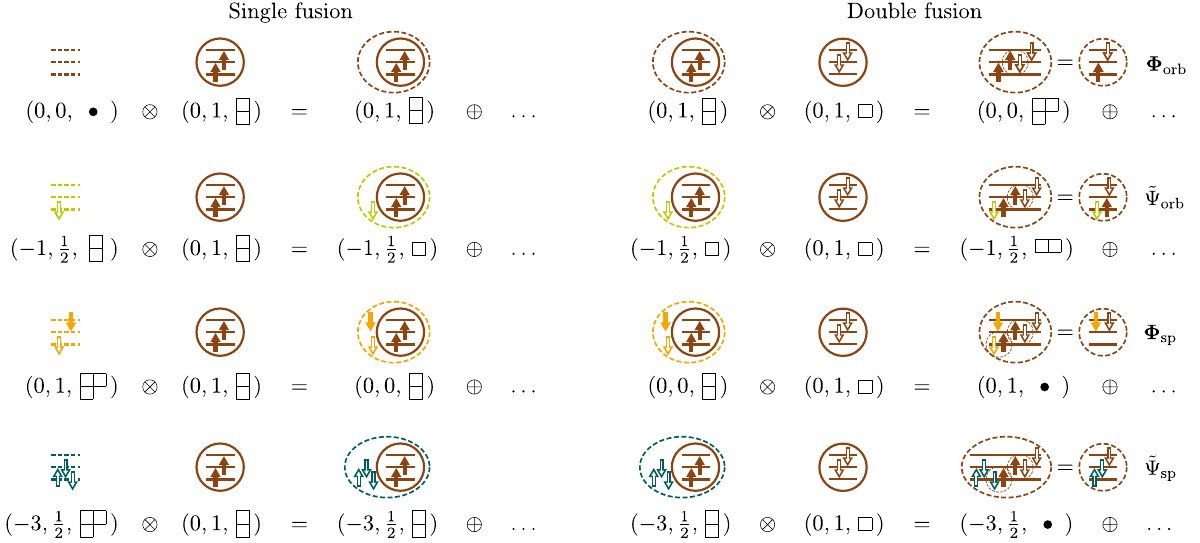
FIG. 3. Schematic depiction of single fusion (left) and double fusion (right), for the four multiplets giving rise to the boundary ˜ Ψ ˜ Ψ operators Φ , Φ , , discussed in Sec. IV (corresponding to rows 1, 3, 4, 5 in Table I). Filled arrows represent electrons, empty orb sp orb sp arrows represent holes. An electron with spin ↑ and a hole with spin ⇓ (missing electron with spin ↑ ) can be combined to annihilate each other, as indicated by small dashed circles in the last column. Our illustrations depict the impurity using a fermionic representation, as would be appropriate for the 3oAH model, even though the 3soK impurity has no charge dynamics. In the “ single fusion ” column, excitations of the free bath are fused with the impurity, , to obtain the eigenmultiplets of the full system at the NFL fixed point. In the “ double fusion ” column (right), the single-fusion results are fused with the conjugate impurity representation, ¯ Q 0 ; 1 ; □ Þ . Each of the resulting multiplets is associated with a boundary operator having the same quantum numbers. Colors imp ¼ ð relate the multiplets obtained after single fusion to the corresponding lines in Fig.